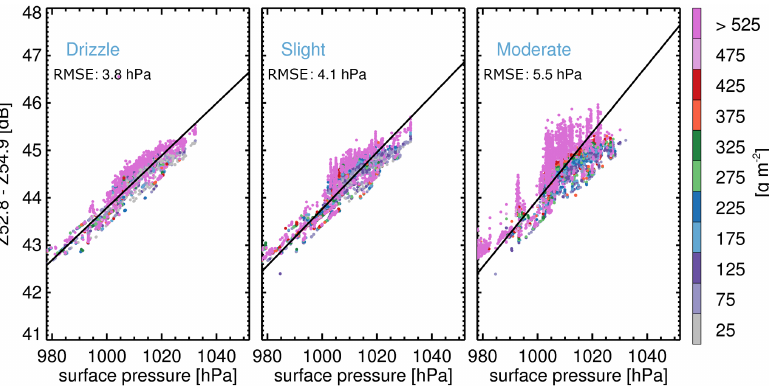
Figure 5. As in Fig. 4 but for precipitating cases. In this case, the total hydrometeor column includes IWC, LWC, rain, and snow. Drizzle, slight, and moderate correspond to rain rates lower than 0.1, between 0.1 and 1, and between 1 and 10mmh − 1 ,